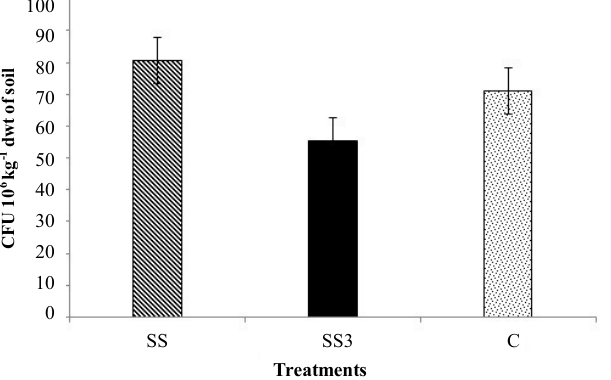
Figure 7. Mean values of colony forming units (CFU) of the fungal communities.